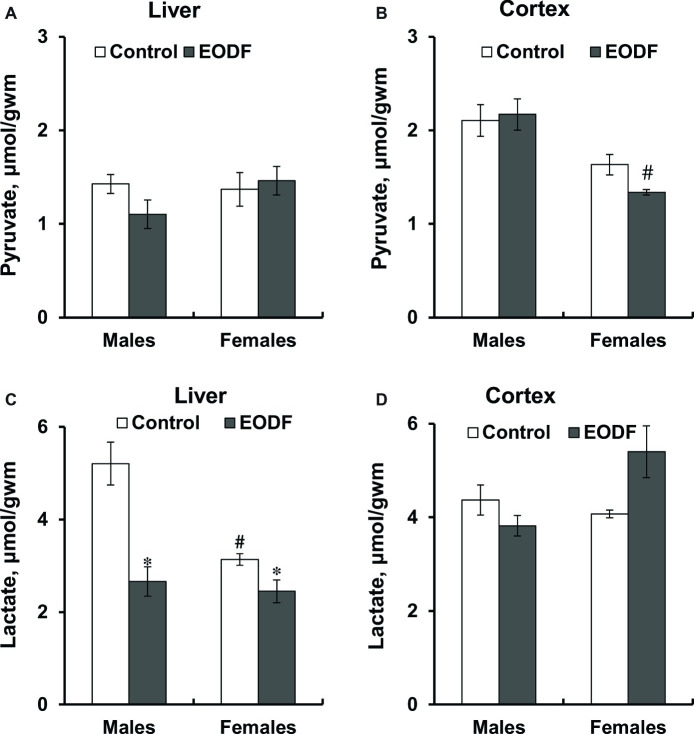
Concentrations of pyruvate (A,B) and lactate (C,D) in the liver (A,C) and the cortex (B,D) of mice fed ad libitum (control) or subjected to an every-other-day feeding regimen (EODF) over 1 month, n = 5–7 mice. *Significantly different from the control group (p < 0.05), #significantly different from corresponding group of males (p < 0.05) by Welch’s t test with Benjamini-Hochberg adjustment of p.